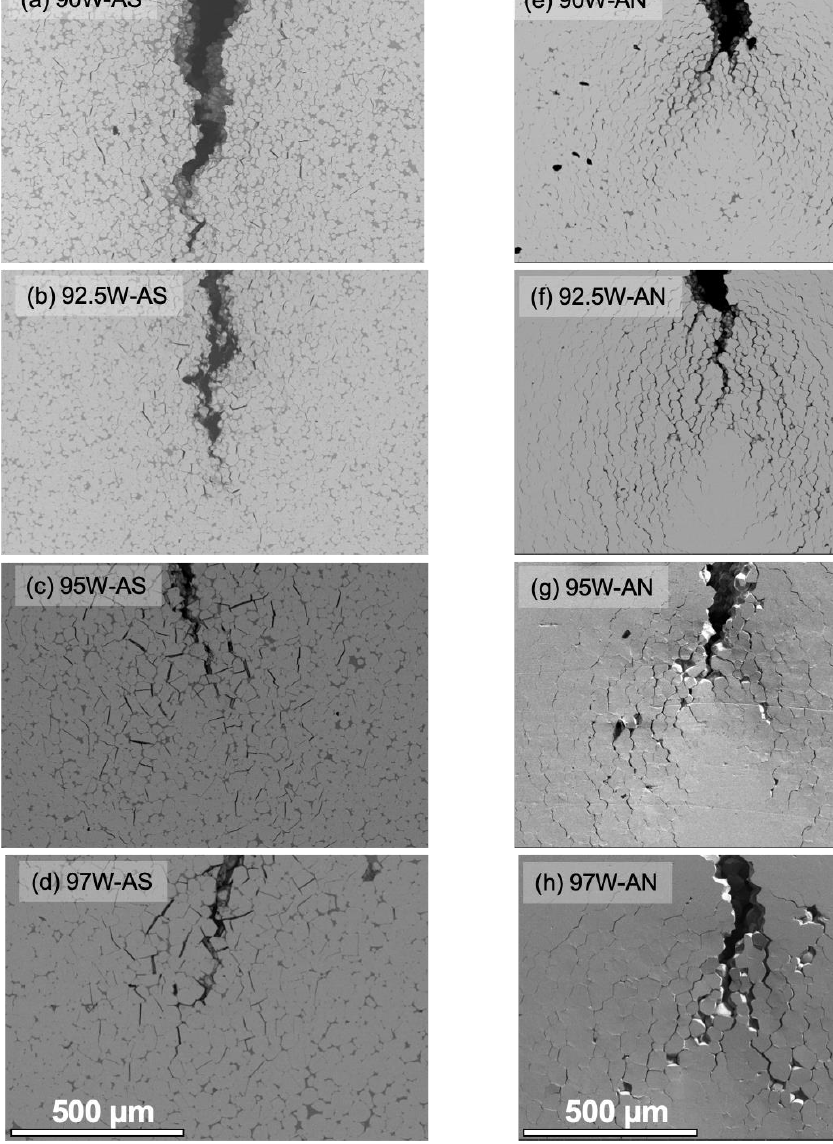
Figure 8. Low magnification SEM images of 1× 90 to 97W propagating cracks in the AS ( a – d , left column) and AN ( e – h , right column) conditions. The scale is 500 µm in all cases.